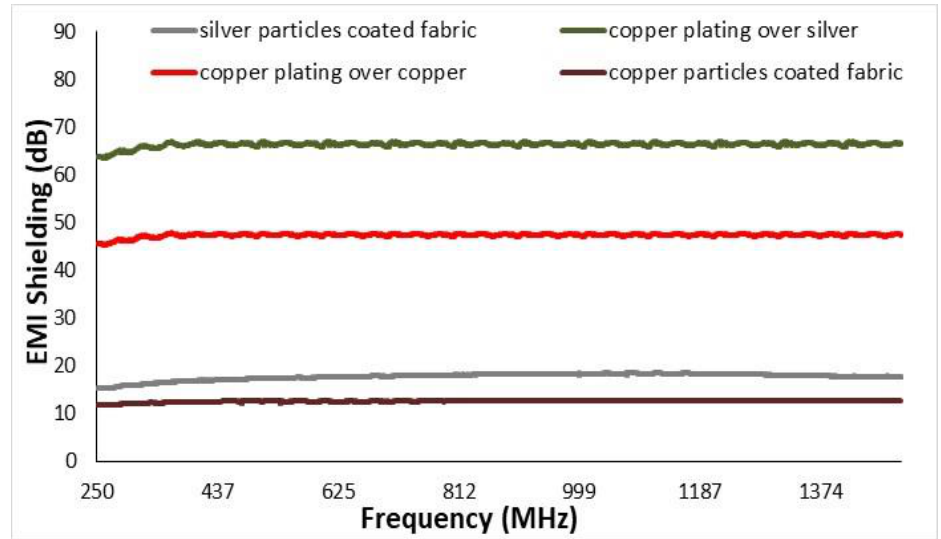
Figure 17. EMI SH Values for Cu-NPs coated fabric and Cu-Electroplated fabric samples.